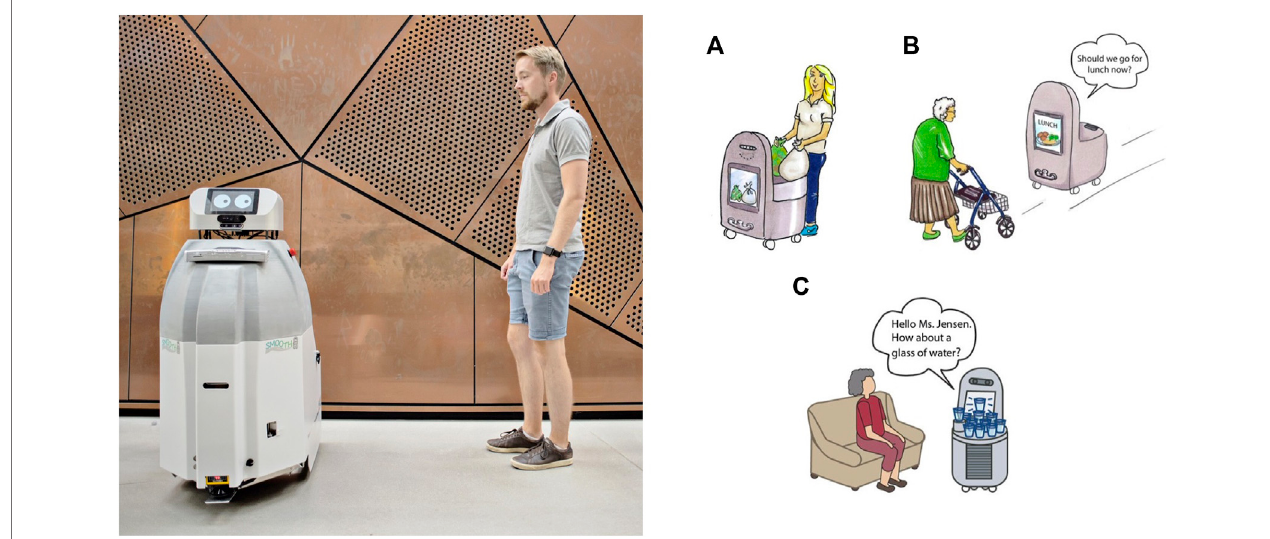
FIGURE1| SMOOTH-robot (A) andthethreeusecasesasoutlinedatthebeginningoftheproject (B) ;a)usecase1:garbageandlaundrytransport,b)usecase2: guiding,andc)usecase3:offeringbeverages.(FigureontheleftprovidedbyMaudLervik/NordiskMinisterråd.FiguresontherightprovidedbytheDanishTechnological